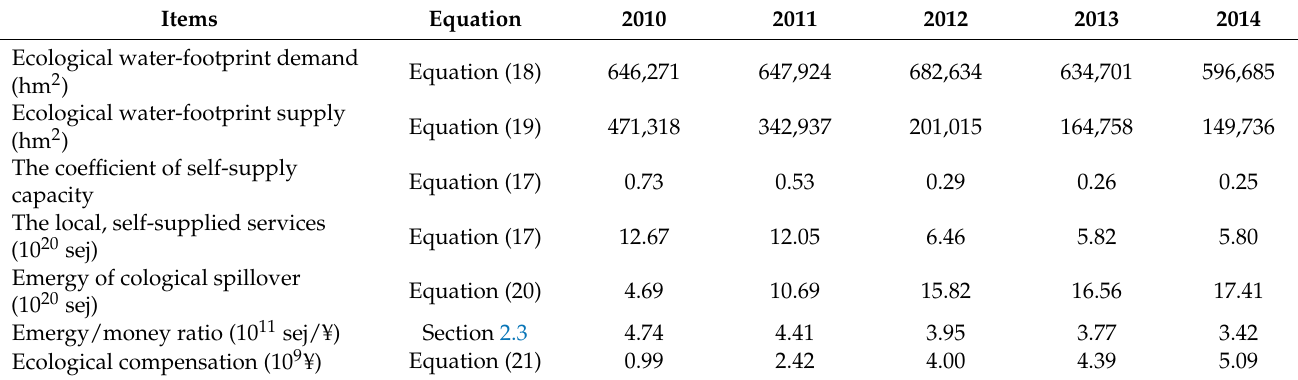
Table 2. Ecological compensation in Qingyi River Basin of Xuchang based on ecological spillover from 2010 to 2014.